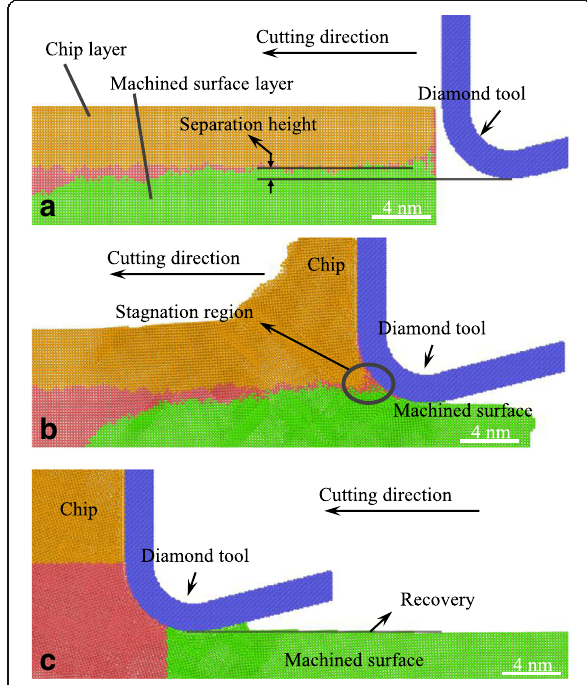
Fig. 11 Snapshots of the MD simulations with the cutting direction of {100}<001> and the cutting distance of a 0, b 12, and c 35 nm